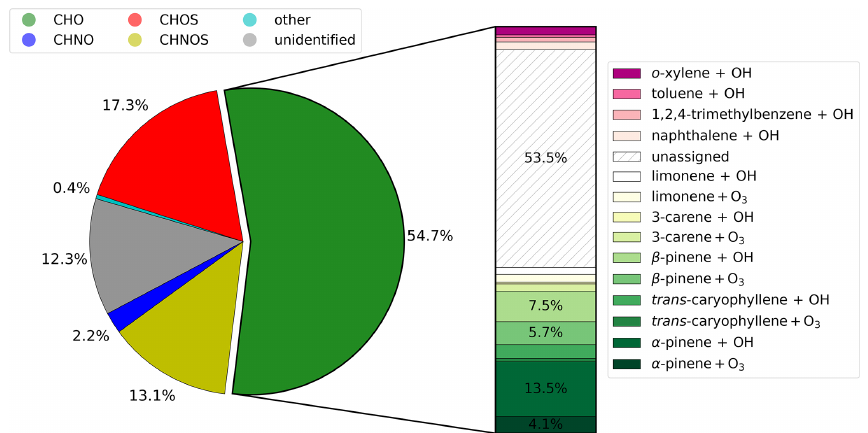
Figure 5. Contribution of different molecular formula groupings to the mean signal intensity of the molecular fingerprint from the represen- tative selection shown in Fig. 4. Compounds of the CHO group were compared to the libraries of the individual OFR experiments presented in Sect. 3.1 and dedicated to a plausible SOA precursor and oxidation condition shown in the bar.